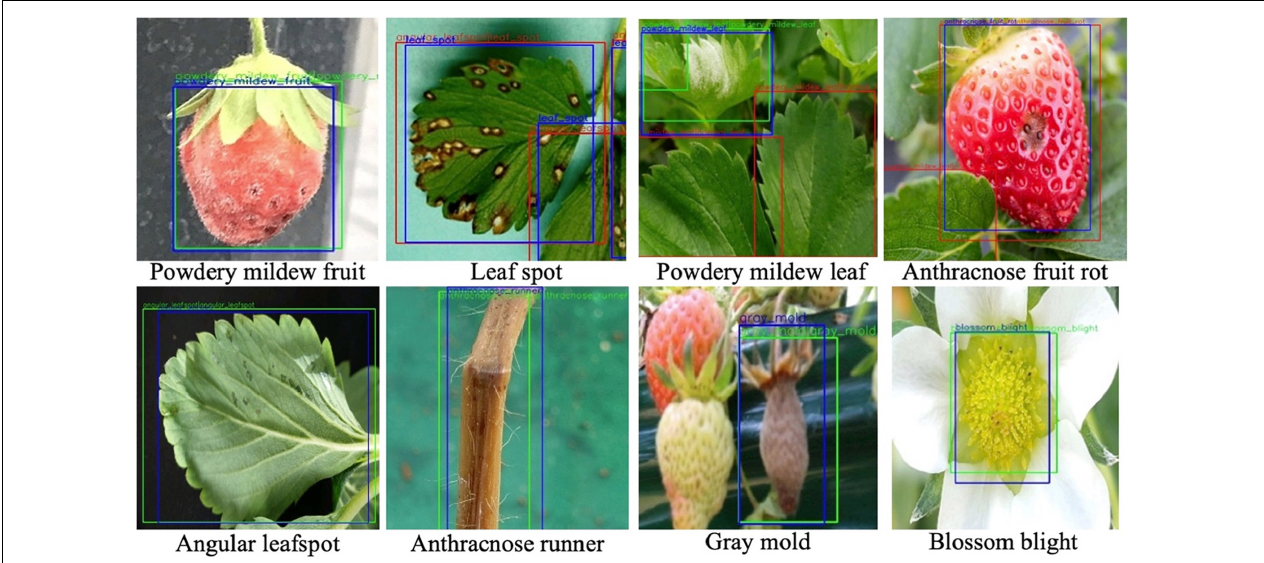
FIGURE 7 | Disease detection results from object detection and post-filter. Objects are annotated by different box colors and prediction labels. Blue bounding boxes are the ground truth annotation. Detected bounding boxes are labeled by “A| B” with two categories; “A” is the prediction result in the first stage, after which the detected area is cropped into patches and sent to the DML and given prediction label B. Green boxes mean prediction labels A and B are the same, otherwise they are red.